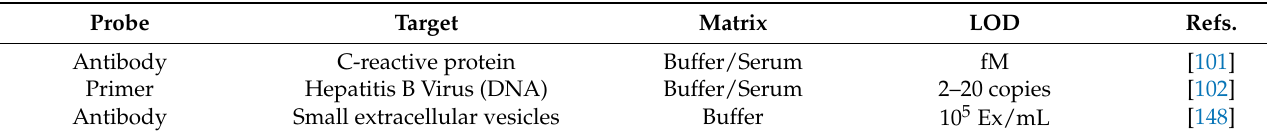
Table 3. Light-emitting Si